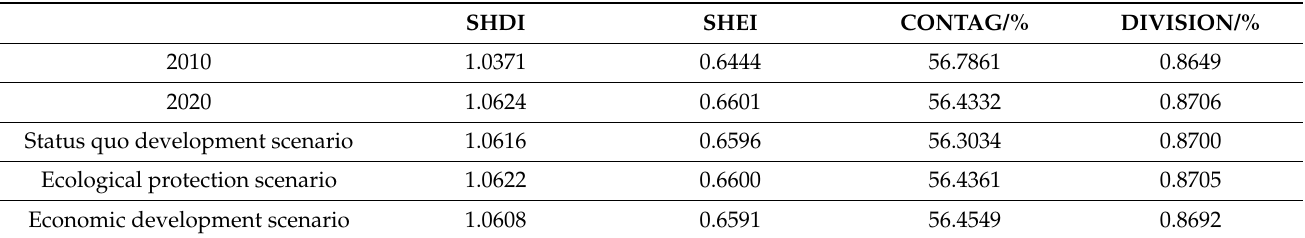
Table 5. Landscape-level indices.